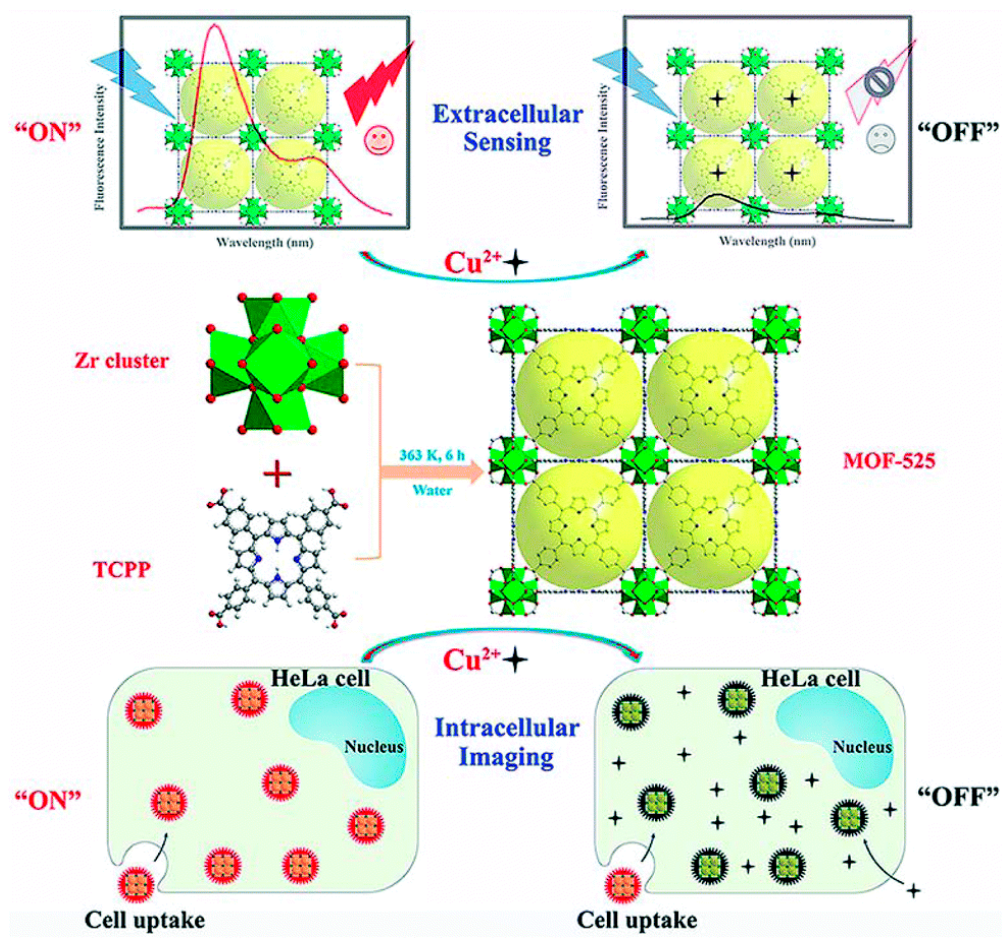
Figure 12. Schematic illustration of the preparation of MOF-525 NPs and the “signal-off” fluorescence sensing for Cu 2+ . Reprinted with permission from ref [58]. Copyright The Royal Society of Chemistry 2019.